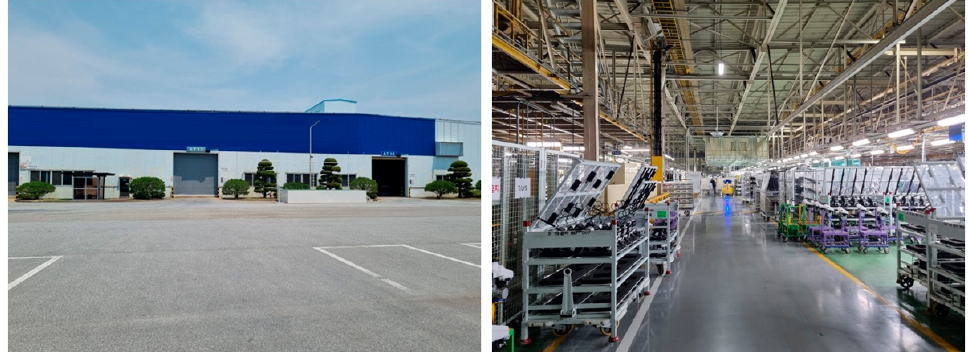
Figure 1. Exterior and interior of the large-scale assembly factory.